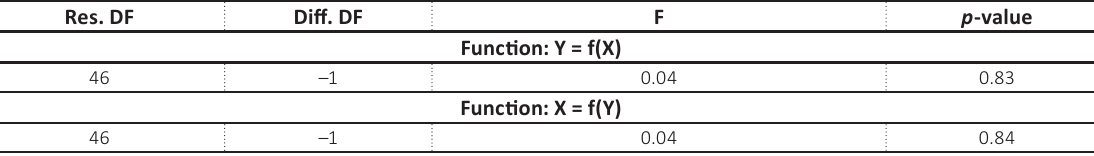
Table E9. Government corporate ESG disclosure (X) and non-government corporate ESG disclosure (Y) Res.